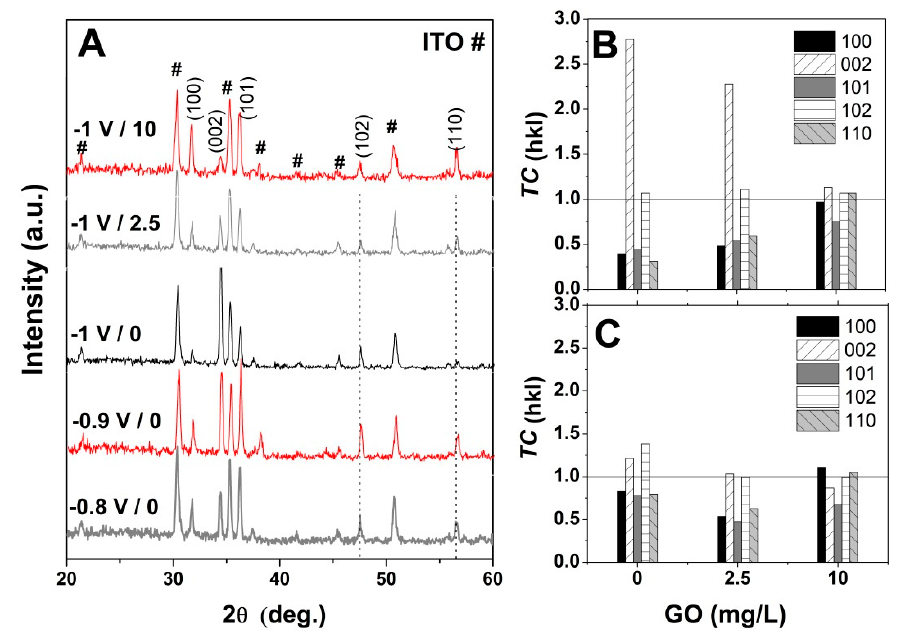
Figure 7. ( A ) XRD spectra evolution of non-modified ZnO with applied potential and GO content (mg L − 1 ); ( B ) and ( C ) texture coefficient ( TC ) evolution of ZnO electrodeposited at − 1 V and − 0.8 V, respectively as a function of the GO content.